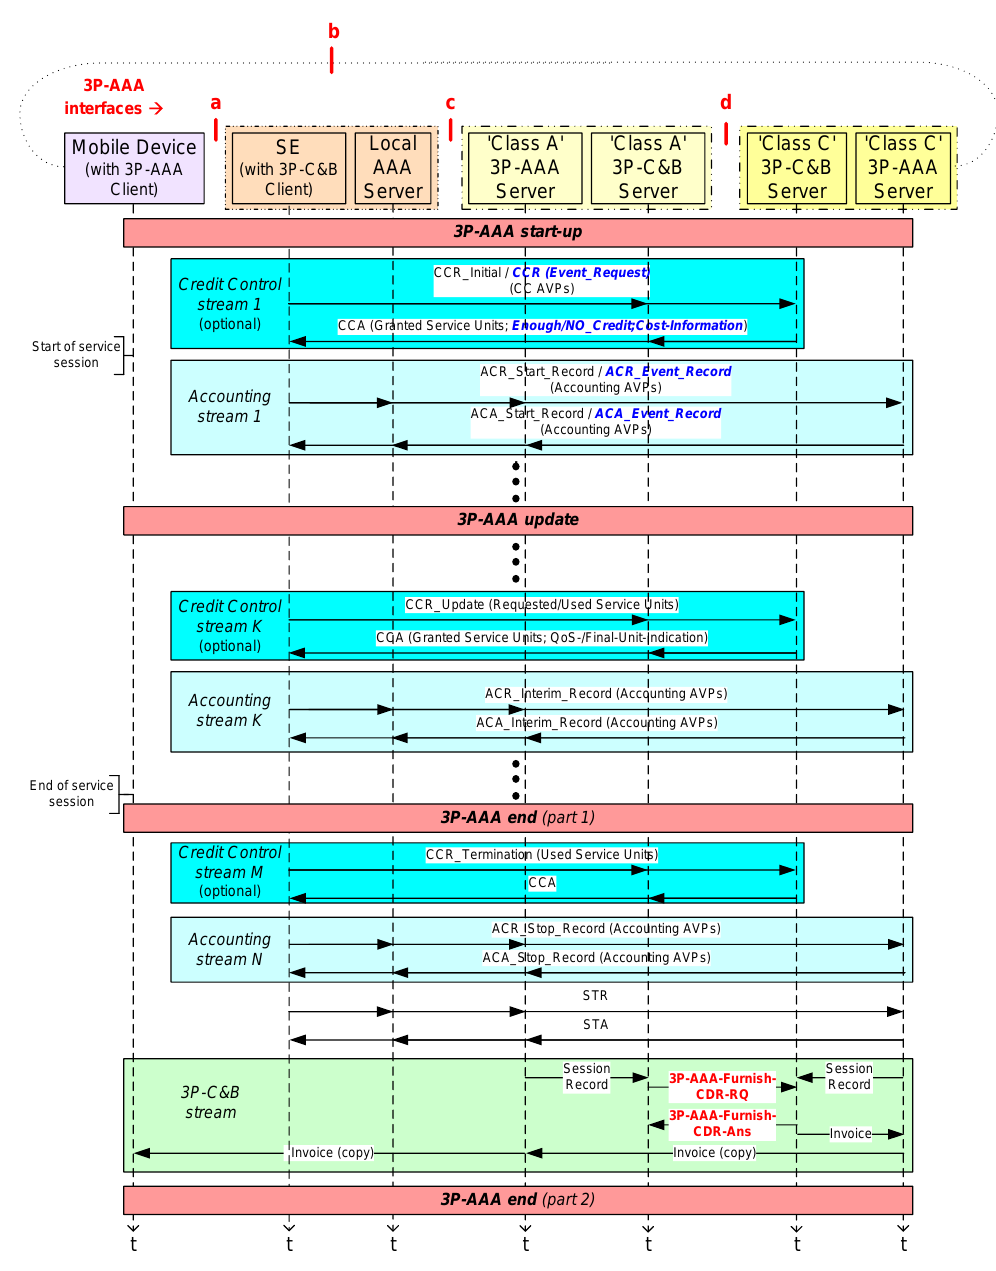
Figure 8. The main signaling traversing the new protocol interface reference points for 3P-C&B Scenario 1 (viewing in color is recommended as color-coding is used).